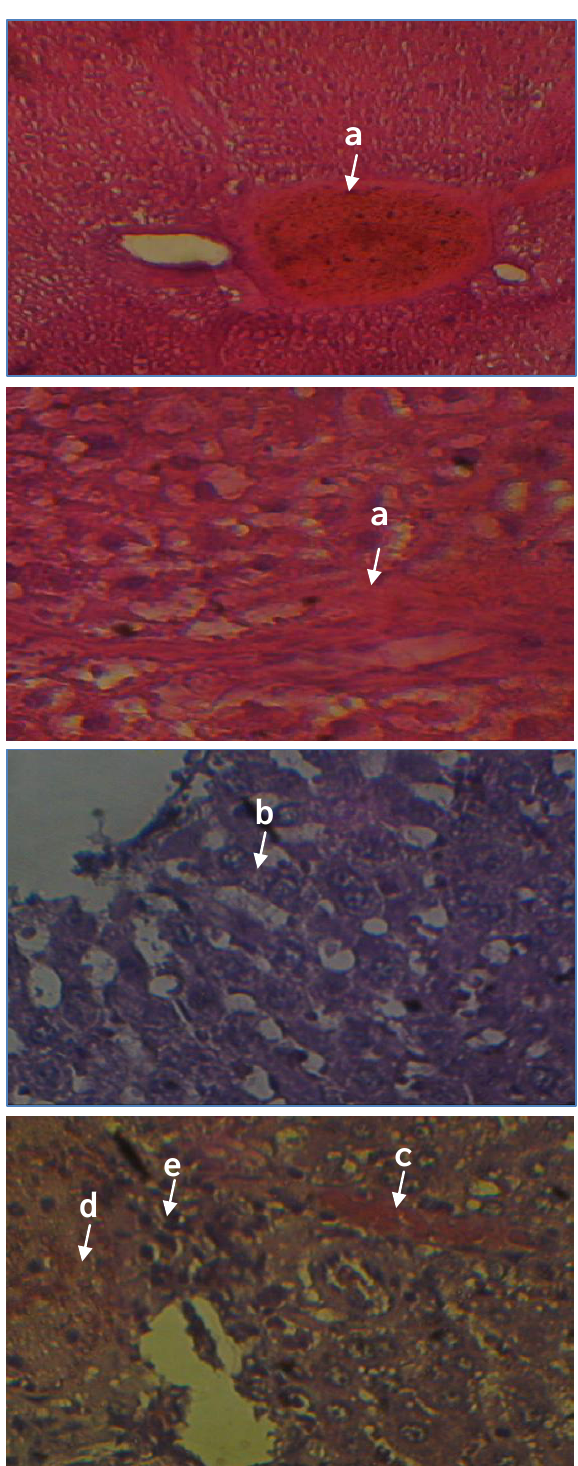
Figure, 1: Effect of DMH induced histopathological changes in rat liver tissue of DMH